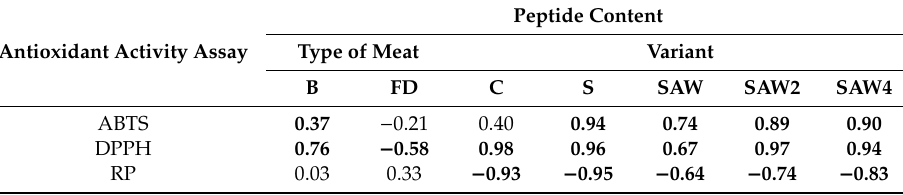
Table 4. Pearson’s correlation coe ffi cient of peptides antioxidant activity measured by three assays (ABTS, DPPH, and RP) and peptide content from fallow deer (FD) and beef (B) sausages made with di ff erent